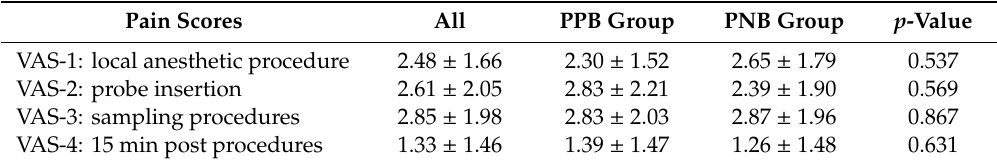
Table 2. Mean VAS pain scores and procedure times in PPB and PNB treatment